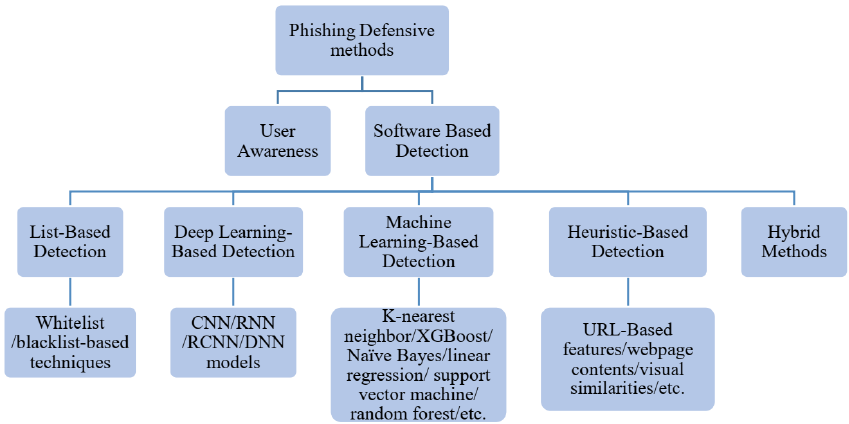
Figure 1. Overview of phishing detection